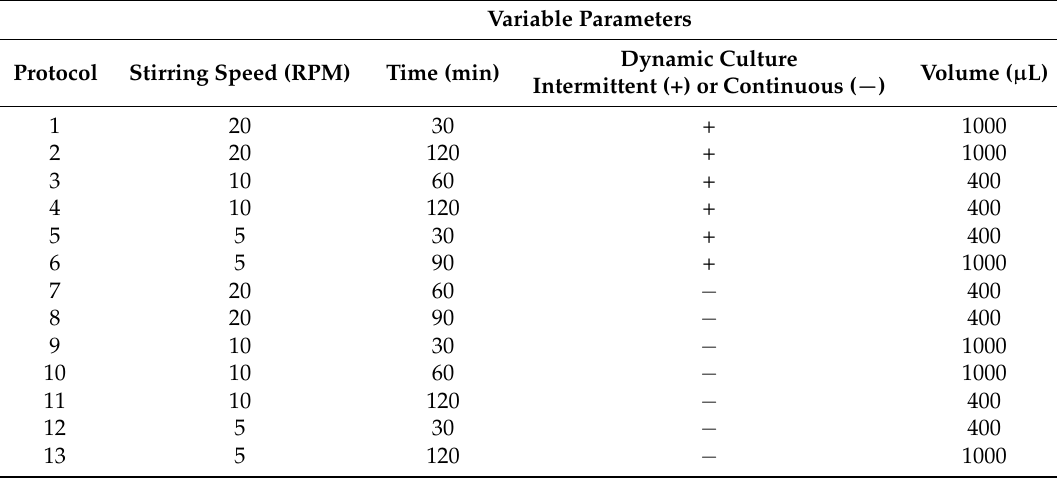
Table 2. DesignofExperiment(DoE)-selectedprotocolsresultingbycombinationofthevariableparameters. Variable